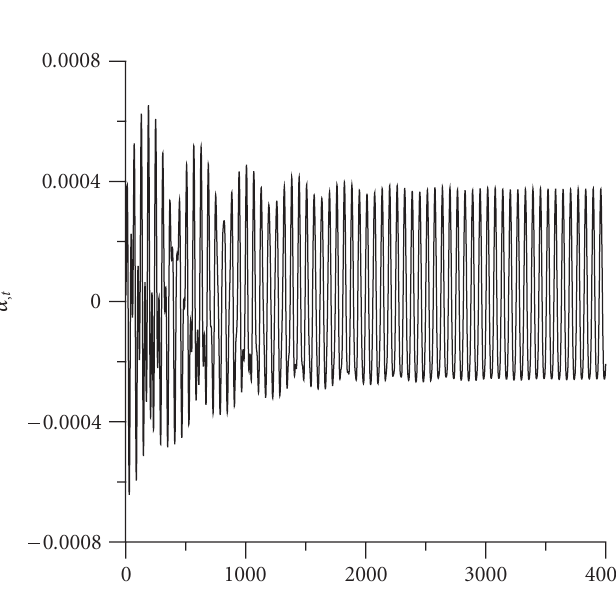
Figure 4.2. Displacements in x = 0 . 5.